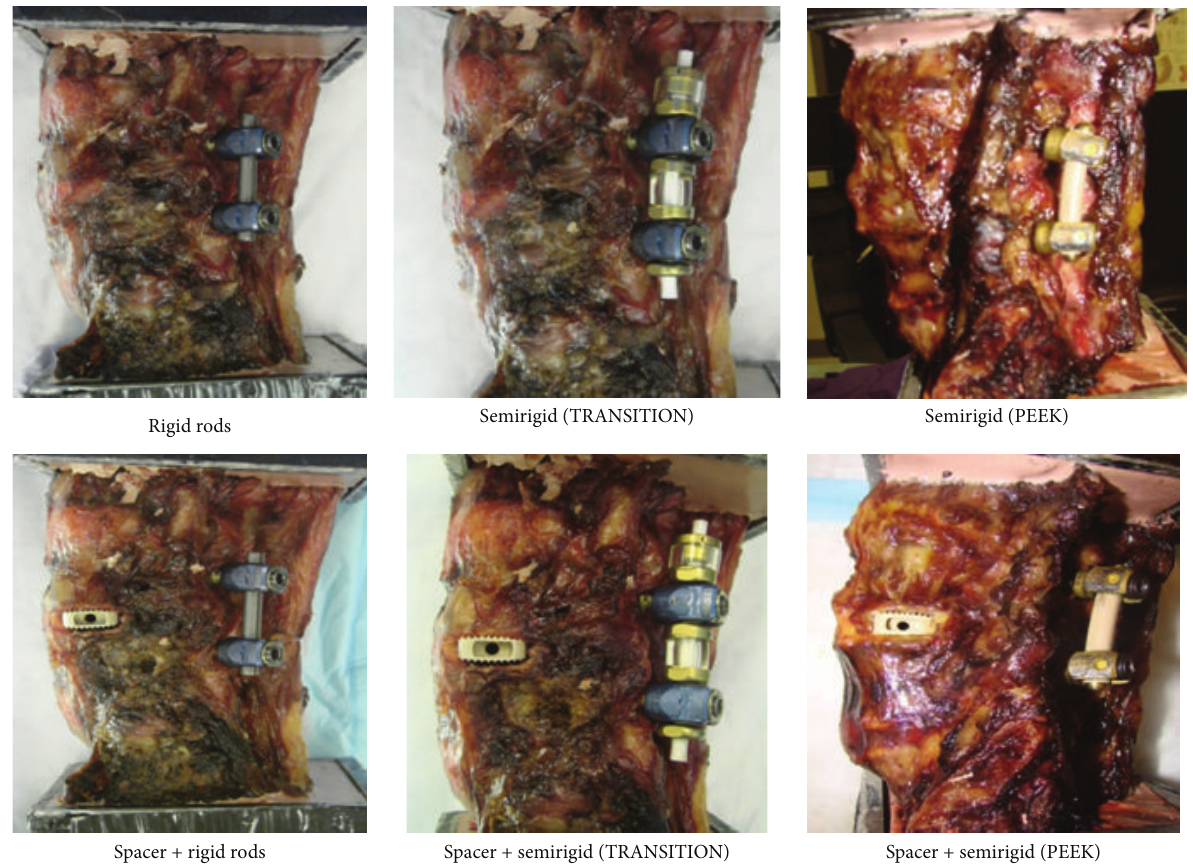
Figure 5: Select test images from flexibility testing, showing rigid and semirigid